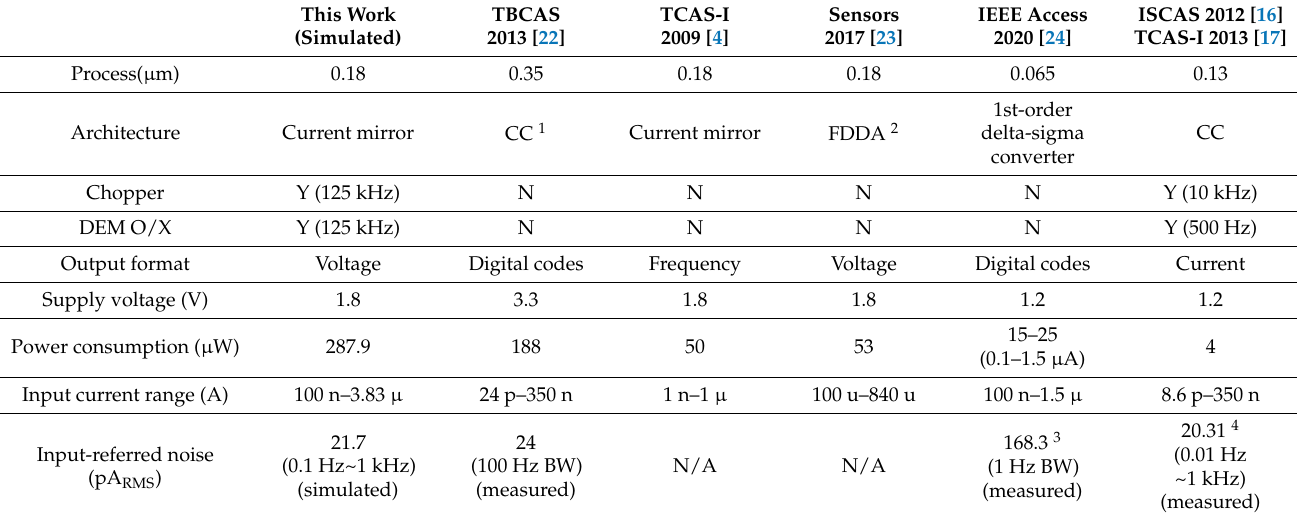
Table 2. Performance summary comparison between the proposed potentiostat readout circuit and previous